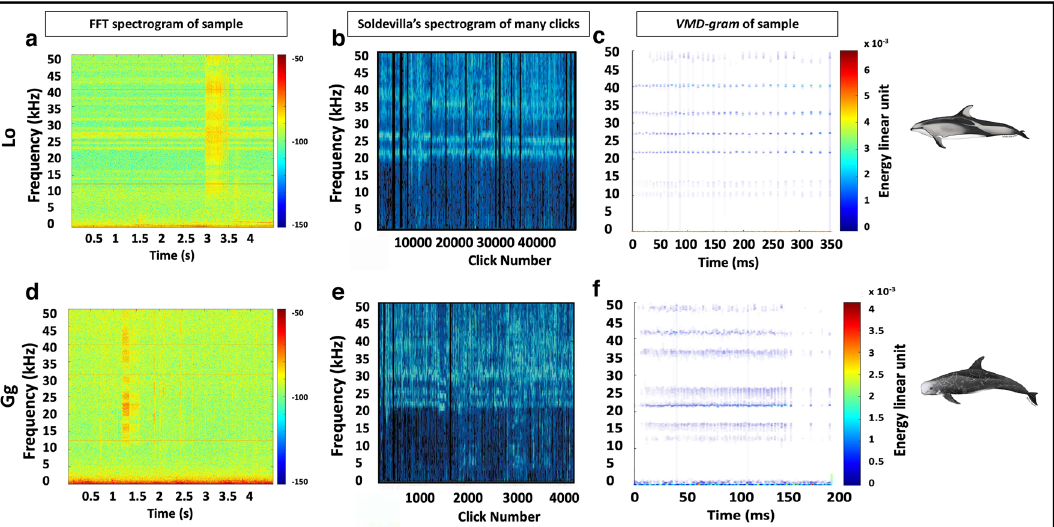
Figure 1. Three visualization tools for delphinid clicks. FFT spectrograms of one sample of a Pacific-white sided dolphin pulsed signal ( a ) and Risso’s dolphin pulsed signal ( d ) compared to the FFT spectrograms of thousands of clicks from each species by Soldevilla et al. (2008) ( b, e ) compared to the VMD-grams of the segments with pulsed signals ( c, f ). Ease of visualizing the peak and notch patterns for manual analysis is more evident in the VMD-gram than in the FFT spectrogram.